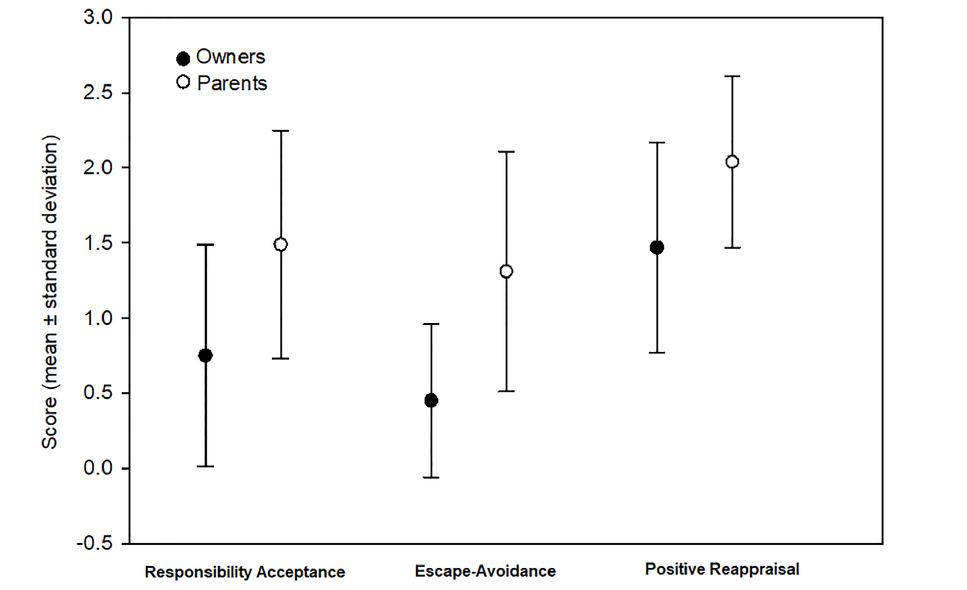
Figure 2. Graph comparing the average scores of parents and owners in the scales Responsibility Acceptance, Escape-Avoidance and Positive